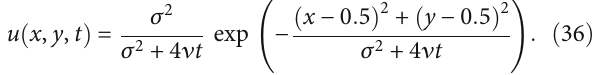
= 20 . Uniform spaced nodes (left) and circular nodes (right), with Neumann t